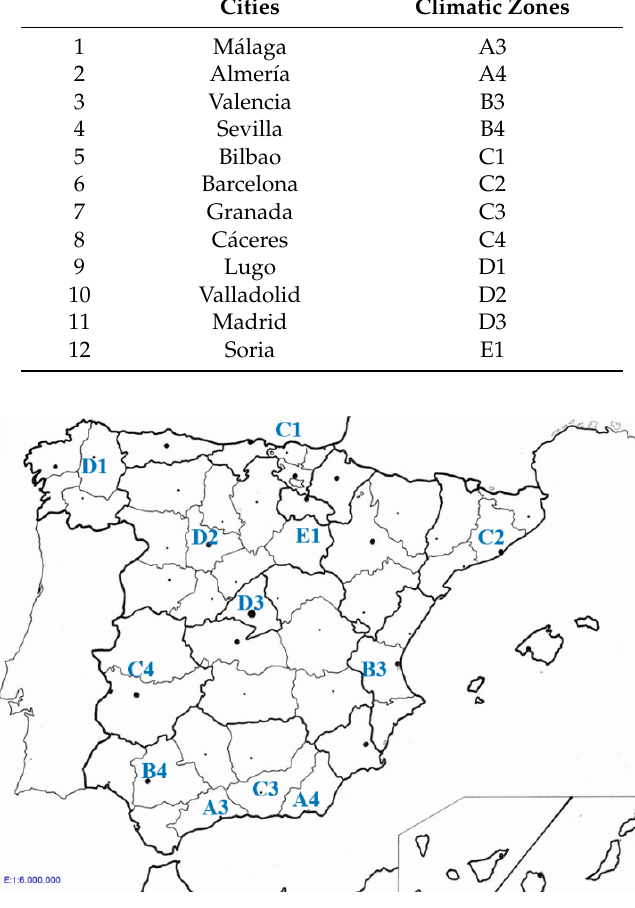
Figure 2. Cities located in Spain.